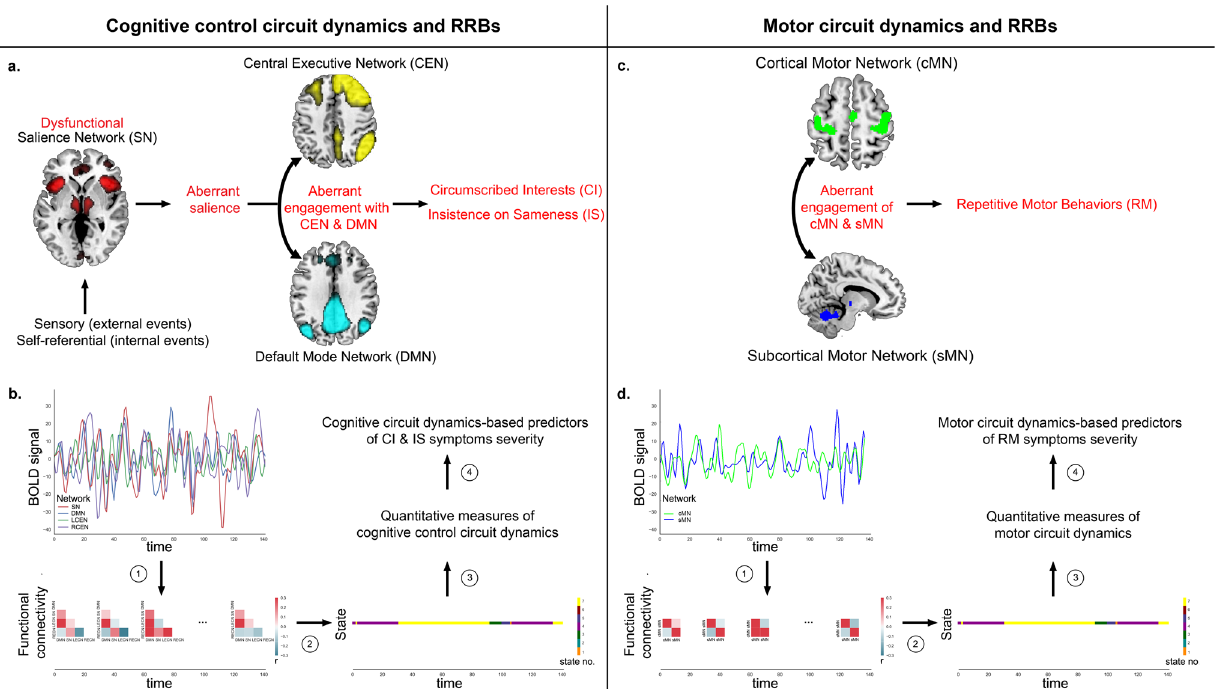
Fig. 1 Overall approach to determine the temporal dynamics of cognitive control and motor circuits and its relationship with Restricted and Repetitive Behaviors (RRBs). a Cognitive control circuit-based model of circumscribed interests (CI) and insistence on sameness (IS) symptoms. The model proposes that aberrant functional of organization of key fronto-parietal-opercular cognitive control circuit may contribute to the cognitive components of RRBs i.e., CI and IS symptoms in children with ASD. Speci fi cally, this model posits a key role for the salience network (SN) in aberrant mapping of internal and external salient events leading to altered dynamic temporal interactions with the central executive network (CEN), and the default mode network (DMN), resulting in CI and IS. b Overall analysis pipeline for examining dynamic time-varying cross-network interactions within cognitive control circuit and their relationship with CI and IS symptoms. Time-varying cross-network interaction was measured using a dynamic functional connectivity approach. (1) We estimated dynamic functional interactions between SN, CEN, and DMN using a sliding-window approach. (2) To identify distinct group-speci fi c states associated with dynamic functional connectivity, we applied a group-wise k-means clustering on the time-series of correlation matrices in each group separately. (3) Brain state-speci fi c network interaction index (NII) was used to characterize cross-network interaction in each dynamic brain state. NII for each state k by averaging NII across sliding-windows labeled as state k. Cognitive NII (CNII) of a sliding window was computed as the difference in correlation between SN and CEN time series and correlation between SN and DMN. The correlation values were extracted from the covariance matrix associated with that sliding window. Mean and variability of time-varying CNII was calculated as average and standard deviation of CNII values across dynamics brain states respectively. (4) Linear regression analysis was used to examine the relation between dynamic time-varying cross-network interactions measure, including mean and variability of time-varying NII, and ADI-R derived RRB subtype symptom severity scores. c Motor circuit-based model of repetitive motor behavior (RM) symptoms. The model proposes that aberrant functional of organization of key cortical-subcortical motor circuit may contribute to the motoric components of RRBs i.e., RM symptoms in children with ASD. Speci fi cally, this model posits a key role for altered dynamic temporal interactions between the cortical motor network (cMN), and the subcortical motor network (sMN), resulting in RM. d Overall analysis pipeline for examining dynamic time-varying cross-network interactions within motor circuit and their relationship with